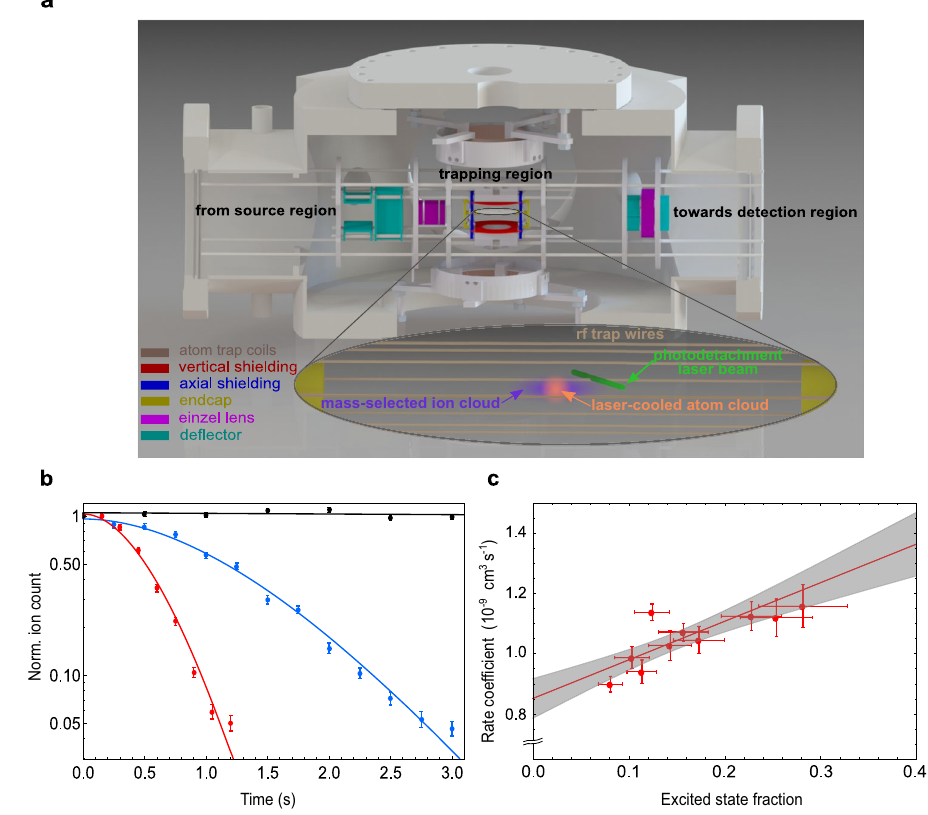
Fig. 2 Hybrid atom-ion system. a The experimental hybrid atom ion trap system. The OH − ions (purple cloud) are created and loaded from the source chamber and trapped in an octupole radio-frequency (rf) wire trap. A far-threshold laser beam (green) is used to determine the ion density via photodetachment tomography. A laser-cooled cloud of ultracold Rb atoms (orange cloud) is overlapped with the ion cloud. As shown here, the spatial extent of the ion ensemble is signi fi cantly larger than that of the atomic cloud. After interaction with the laser or atoms, the time of fl ight of the ions are extracted onto the detector. b The detected normalized OH − ion count after reaction with the laser-cooled rubidium atoms for excited state fractions of 0.10(2) and 0.28(5) (blue and red data points, respectively). The gray data points depict the ion losses without the presence of rubidium atoms. The ion losses are fi tted by Eq. (1) (solid lines). The error bars represent the statistical errors. c Reaction rate coef fi cient as a function of the excited state fraction. The solid red line is a linear fi t through the data points. The slope and intercept of the fi t yields the reaction rate coef fi cient for the excited state and ground state rubidium interacting with OH − , respectively. The gray shaded area represents the 1- σ range of statistical